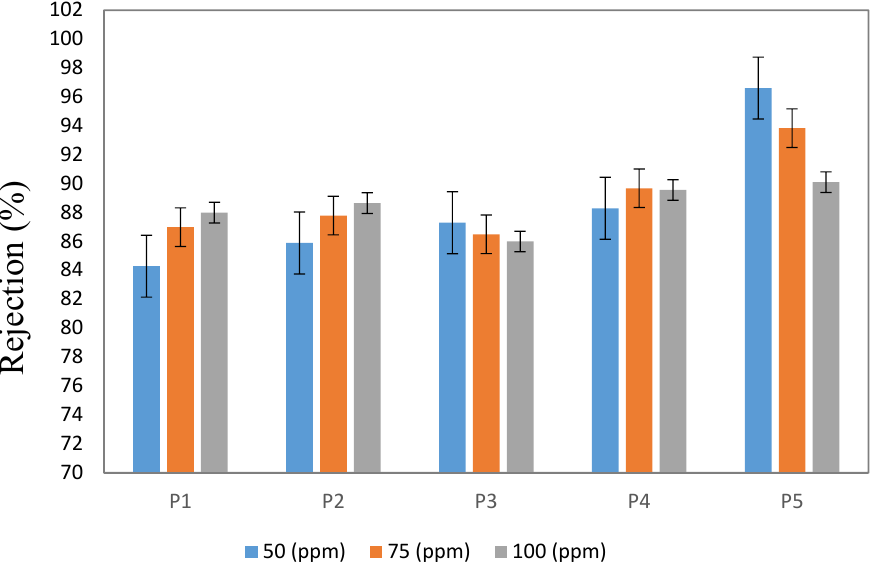
Figure 10. E ff ect of PES content on the membrane rejection for various feed dye concentrations.